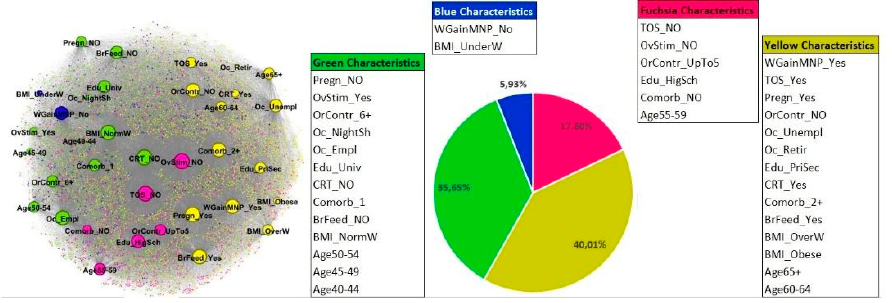
Figure 3. Graph layout and composition of communities within the profile 2. The pie chart repre- sents the percentages of women belonging to each community. the percentages of women belonging to each